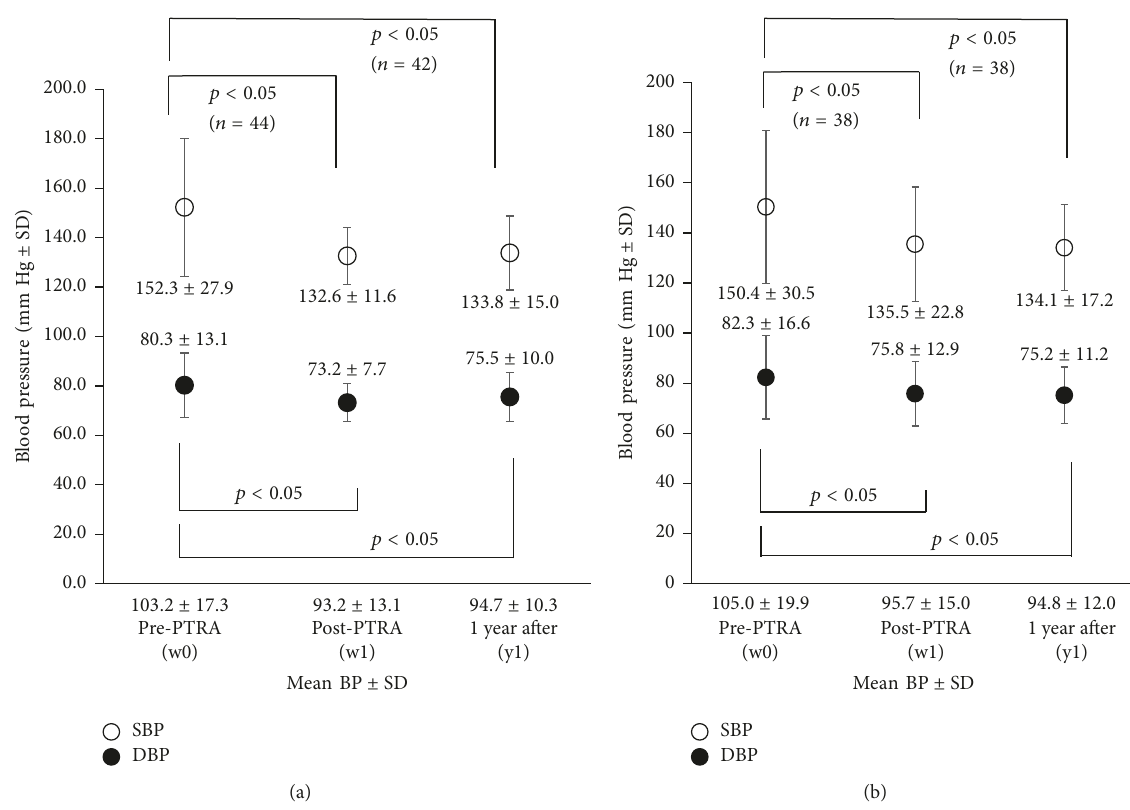
Figure 1: Change in blood ressure. (a) All cases. (b) Atherosclerotic RAS only. SBP and DBP were significantly reduced after PTRA, and the BP lowering effects continued until 1 year after. RAS: renal artery stenosis; BP: blood pressure; SBP: systolic BP; DBP: diastolic BP; PTRA: percutaneous transluminal renal angioplasty; SD: standard deviation.